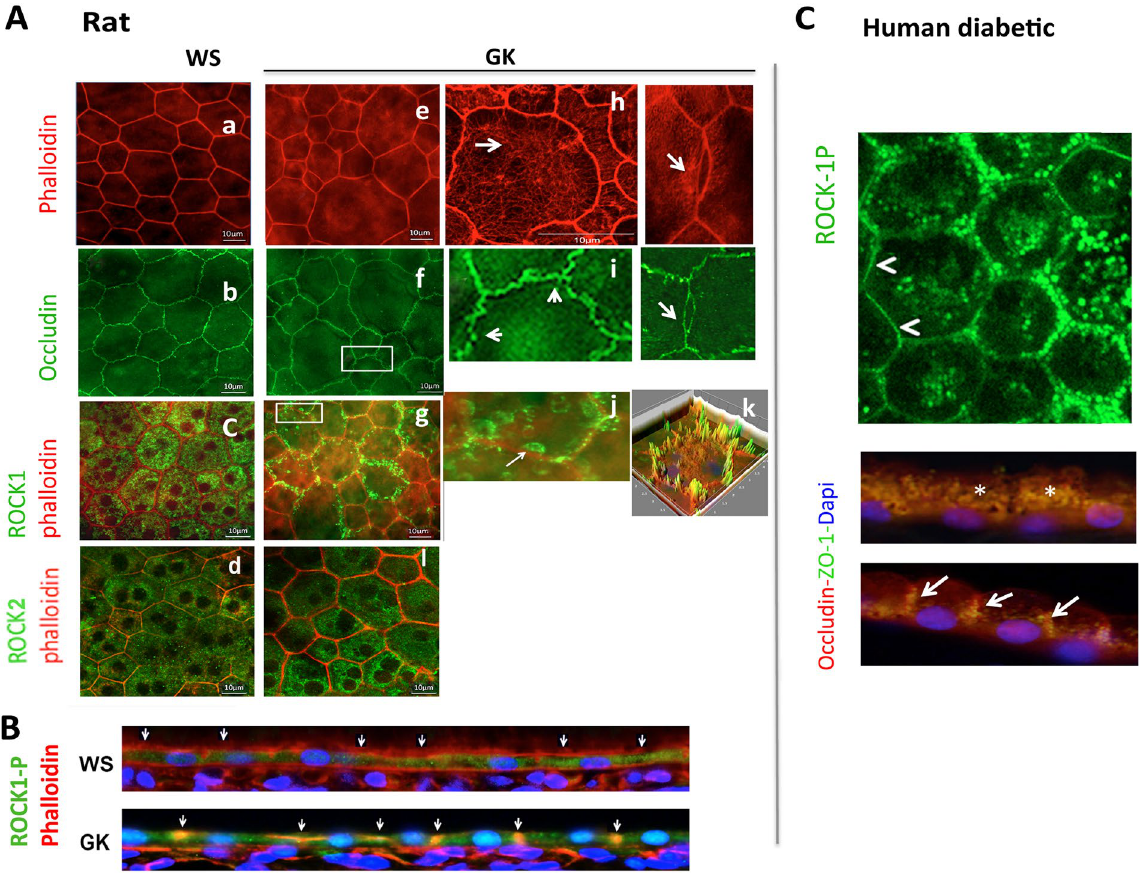
Figure 3. ROCK-1 and ROCK-2 distribution in diabetic retinal pigment epithelial cells (RPE) and ROCK-1 recruitment in membrane blebbing. ROCK1-phalloidin double staining (ROCK-1 in green, phalloidin in red and DAPI in blue) and occludin (green) on: ( A,B) Rat retina, ( C ): Human retina. In non-diabetic WS rats, phalloidin labelled the regular hexagonal cytoskeleton of RPE cells ( A ,a). In GK rats, cytoskeleton rearrangement with shape and size modifications of RPE resulting in cell constrictions with reduced area and stress fiber formation are observed ( A e,h). Regular occludin stain the WS RPE (b), but focal occluding disruption and opening are observed in GK RPE (f,i). ROCK-1 is cytoplasmic in WS but translocated at the membrane in GK RPE (c,g,j,k) and ROCK-1 positive blebs are observed in GK RPE ( A ,j). Transversal section of RPE confirms the membrane translocation of ROCK-1 in the diabetic RPE ( A ,k), demonstrating that ROCK-1 is activated in GK RPE. Similar faint membrane and perinuclear distribution of ROCK-2 is observed in WS and GK rats (d,i). ( C ) In human RPE, ROCK-1 is recruited at the membrane (white arrows on flat-mounts and on RPE section). Scale bar = 10 µ